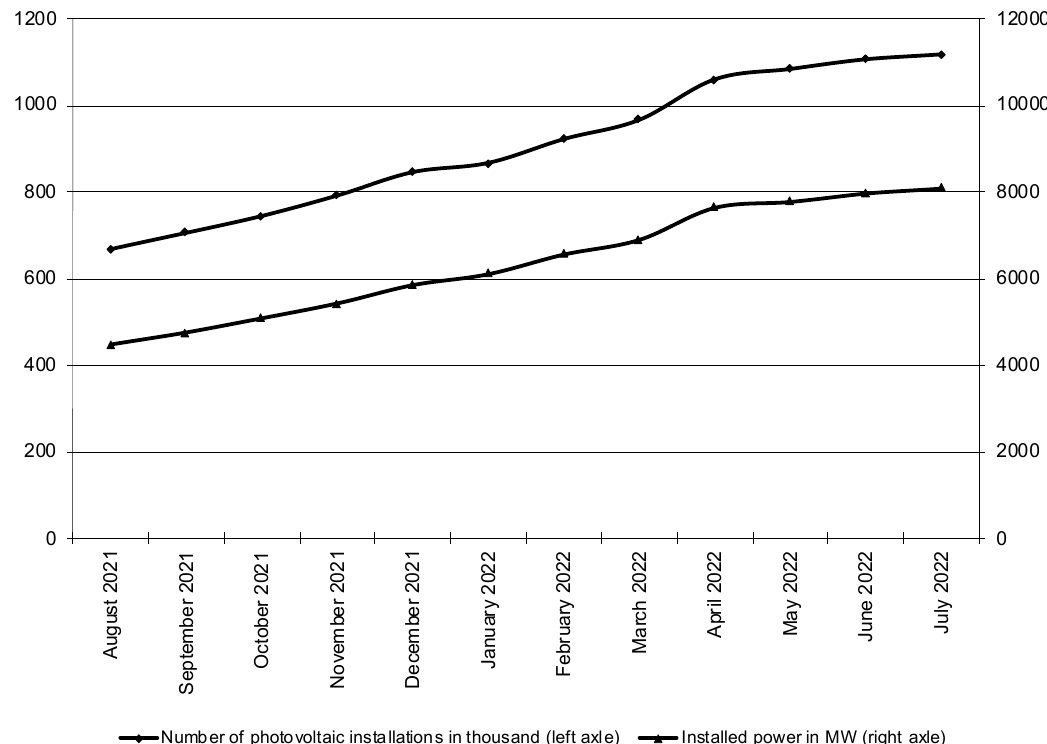
Figure 2. Number (thsnd) of photovoltaic installations in Poland and their capacity from August 2021 to July 2022. Source: author’s work based on Energy Market Agency [56,57].